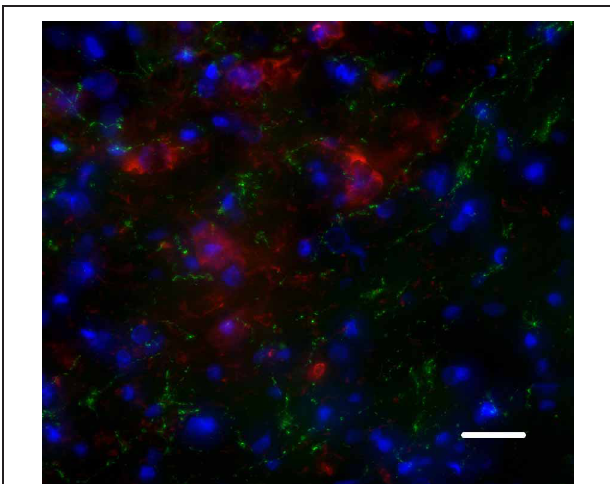
FIGURE 2 | Human neuronal precursors grafted into the post-ischemic striatum project onto the host substantia nigra, a normal target of medium spiny GABAergic neurons. Green: MTCO2, a maker of human fibers; Red: TH, a marker of substantia nigra dopaminergic neurons. Scale bar: 20 μ